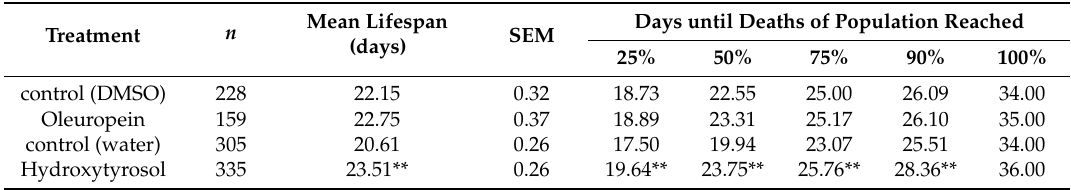
Figure 3. E ff ect of OLE and HT on lifespan in C. elegans . The survival curves of controls and polyphenol-treated nematodes are shown. Survival is expressed as a percentage of the initial population per day. ( A ) The curve represents two independent experiments ( n control = 184, n OLE = 111); ( B ) Representative survival curve of three independent experiments with control and HT-treated worms ( n control = 250, n HT = 286). Statistical significance was calculated by log-rank test; di ff erences compared to control were considered significant at p < 0.05 (*) and p < 0.001 (**). n : number of tested nematodes. Table 1. Lifespan characteristics during OLE and HT